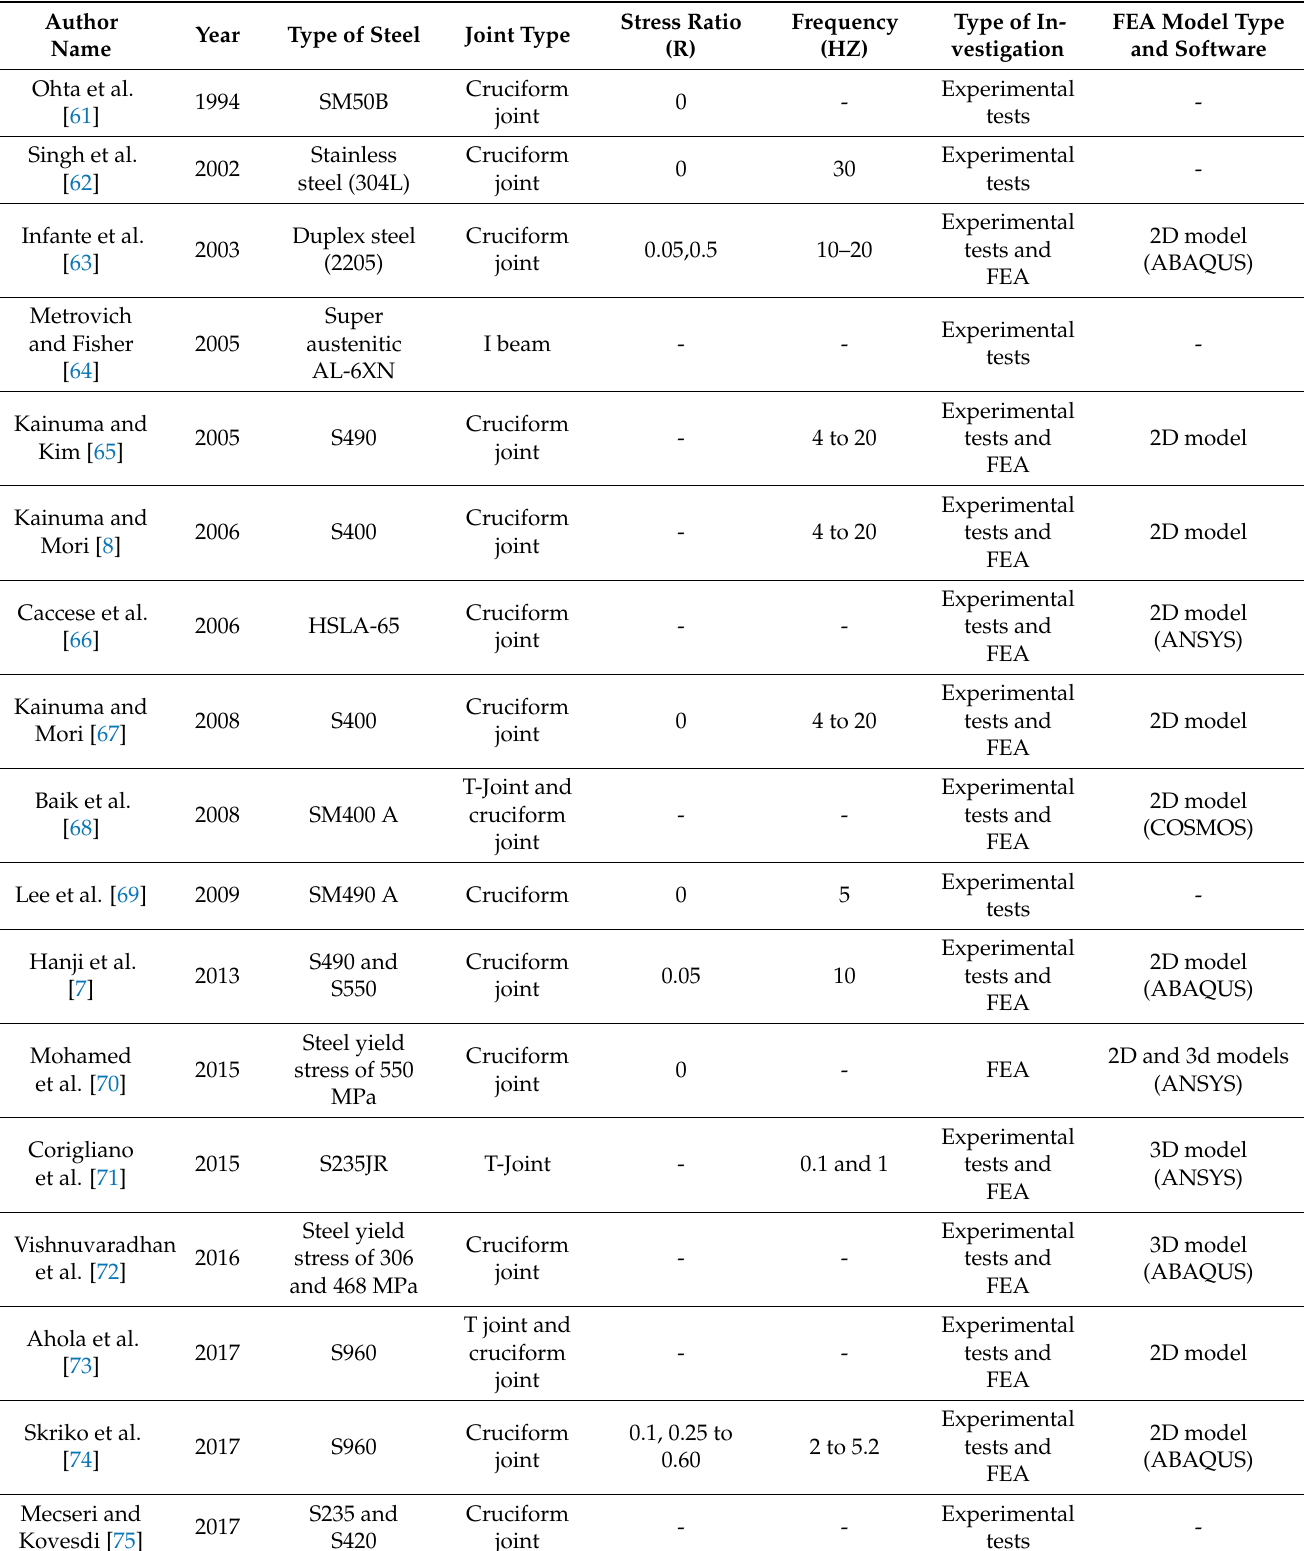
Table 2. Fatigue strength of fillet welded